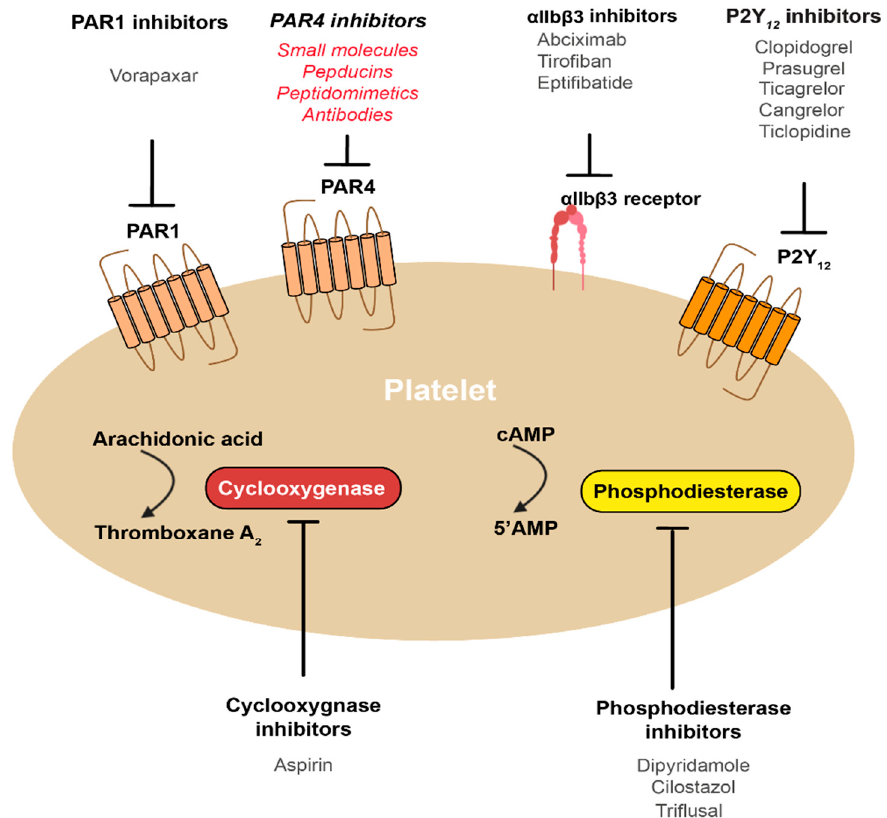
Figure 1. Currently available anti-platelet agents (black text) target five distinct platelet proteins: Cyclooxygenase (aspirin), P2Y 12 (clopidogrel, prasugrel, ticlopidine, ticagrelor, cangrelor), α II b β 3 (abciximab, tirofiban, eptifibitide), phosphodiesterase (dipyridamole, cilostazol, triflusal) or PAR1 (vorapaxar). PAR4 is an emerging target for anti-platelet drugs, with a number of different strategies to inhibit the receptor currently being pursued, as indicated (red italicised